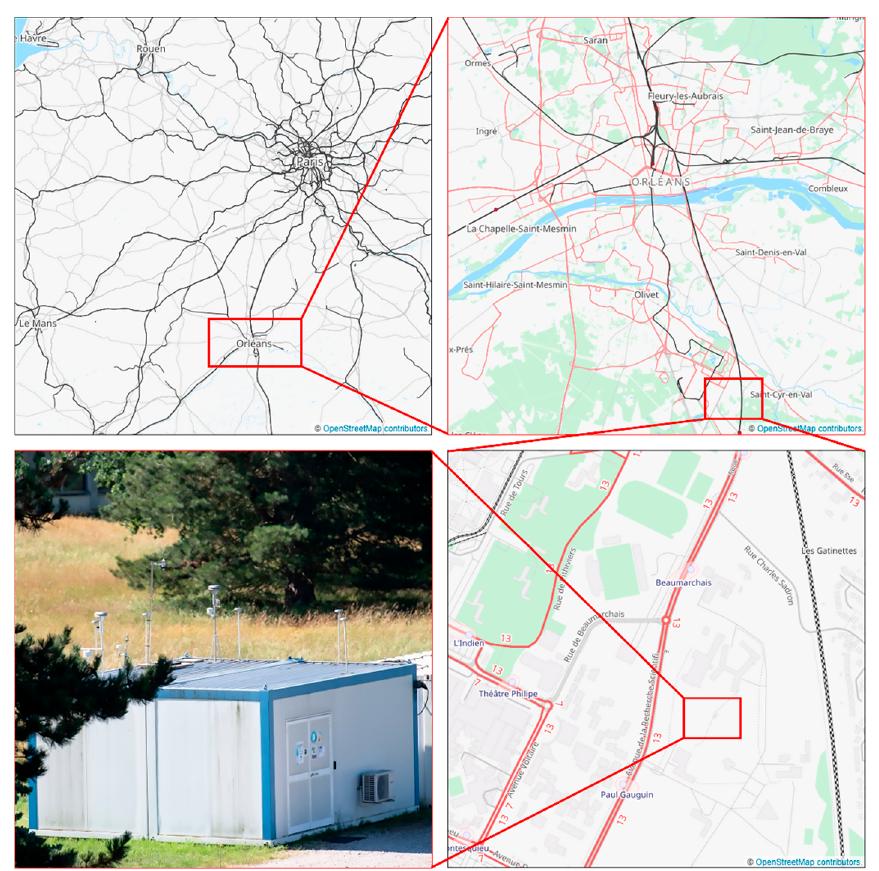
Figure 1. Location of the sampling site at the CNRS-campus in Orléans, France.